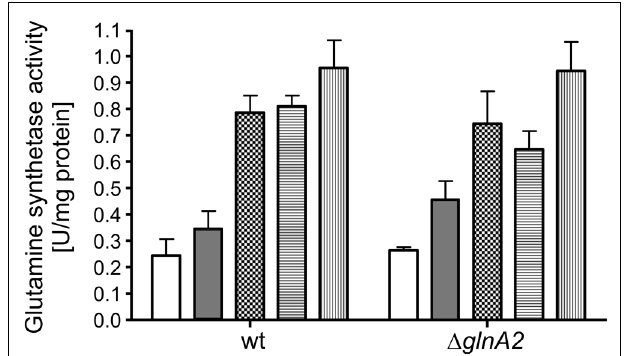
FIGURE 6 | Glutamine synthetase activity is salt-induced in Halobacillus halophilus wild type and (cid:2) glnA2 mutant. Cells were grown in NB medium with 1 M NaCl, permeabilized and harvested in the late exponential growth phase. Cells were washed in an isoosmolar KCl solution, resuspended in 1.5 M KCl solution and exposed to the activity measurements, in which 0 (no fill), 0.5 (gray), 1.0 (squares), 2.0 (horizontal lines), and 3.0 (vertical lines) M KCl, respectively, were present.The values represent the means and the SEMs of three physiologically independent parallels.